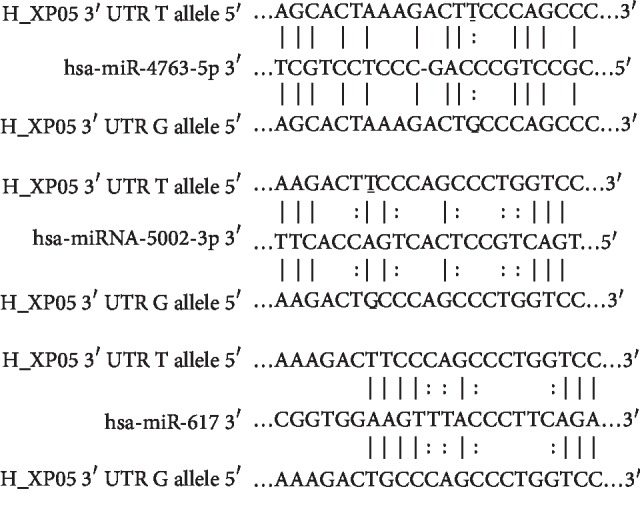
Predicted binding of the candidate miRNAs (miR-4763-5p, miRNA-5002-3p, and miR-617) to SNPrs11077 of XPO53′UTR.